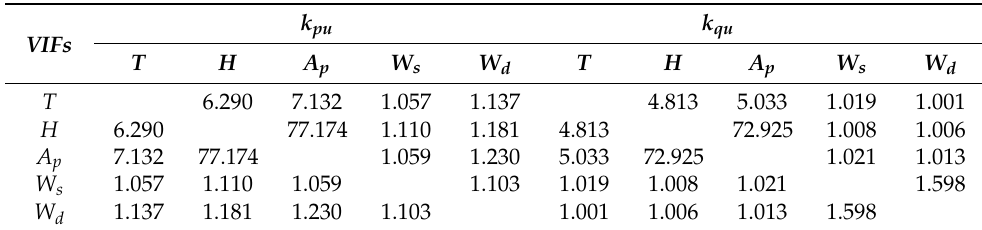
Table 1. VIFs between meteorological variables when k pu and k qu are calculated according to Equa- tions (7) and (8).